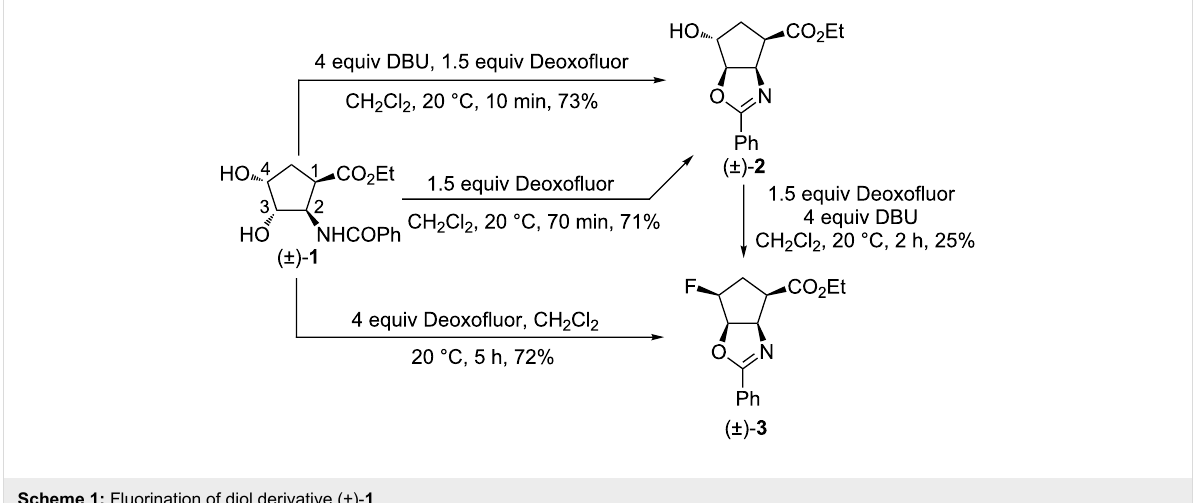
Scheme 1: Fluorination of diol derivative (±)- 1